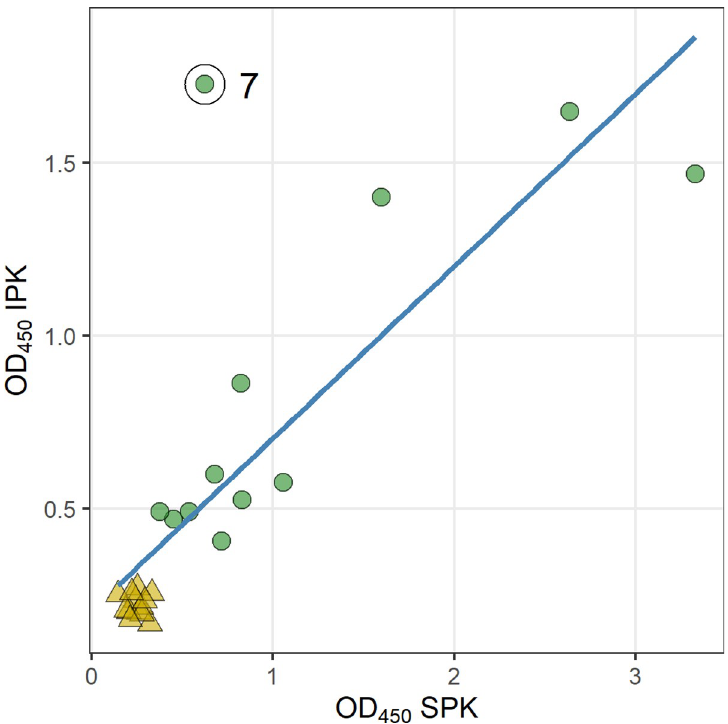
Fig 6. Correlation of IPK vs. SPK. Optical density at 450nm for C-ELISA using SPK is plotted on the x-axis; optical density at 450nm for C-ELISA using IPK is plotted on the y-axis, and a regression line is shown (r 2 = 0.63). Triangles indicate samples that were non-TB by clinical assignments; circles were TB-positive. The non-TB samples clustered together separately from TB-positive samples in both ELISAs. Sample 7 had an unusually high reading by IPK, as indicated by the circled and labelled point. CS35 IgG is used as the capture mAb and A194-01 IgG1 is used as the detection mAb in the assay.